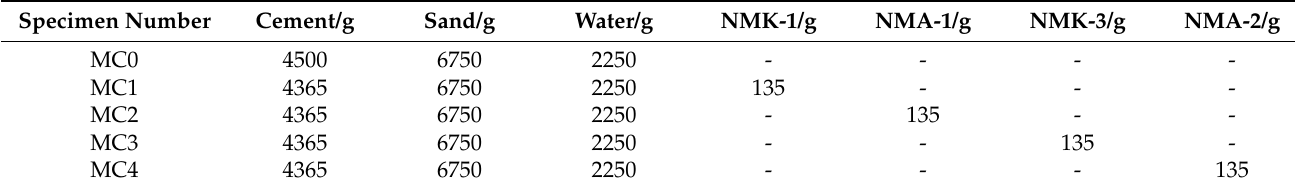
Table 3. Mix proportion of cement mortar.